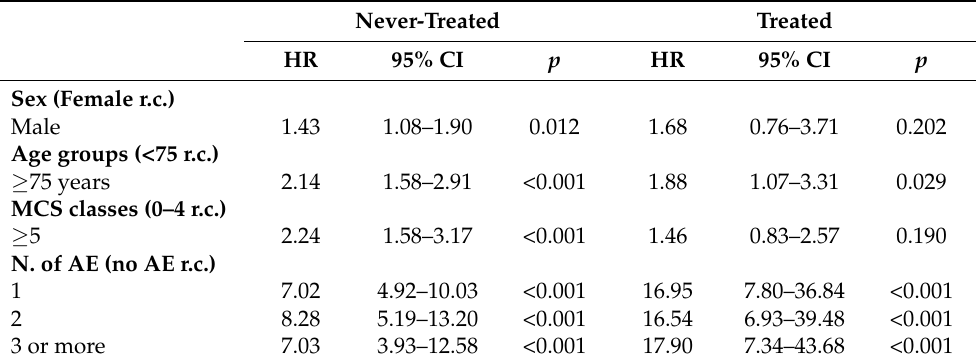
Table 3. Cox proportional hazard model for the risk of death. The number of AEs has been considered as a time-dependent variable. The analyses were stratified according to